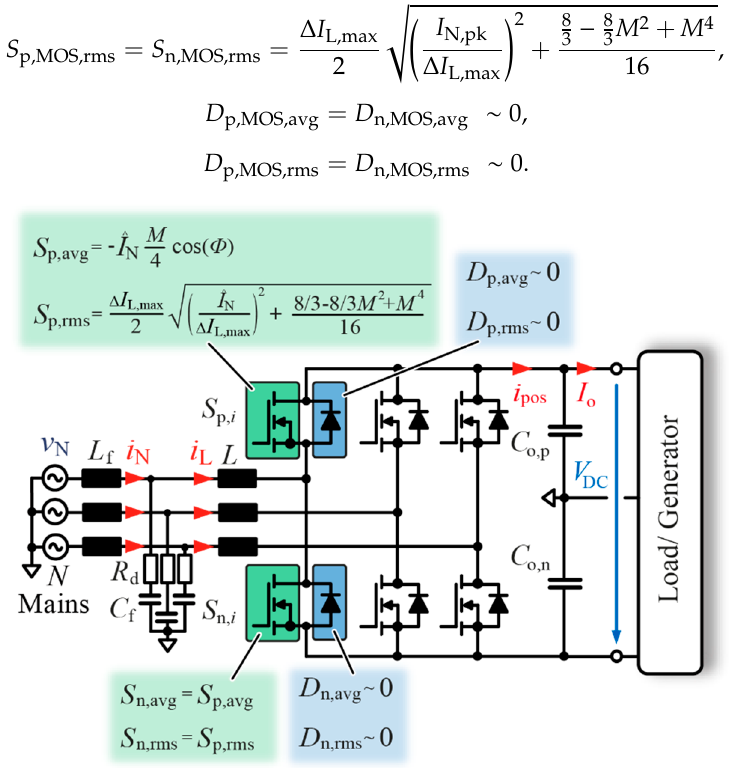
Figure 7. Current stress of a MOSFET-based three-phase six-switch inverter topology, incorporating the existing current ripple, as in particular relevant for light- and no-load operation.